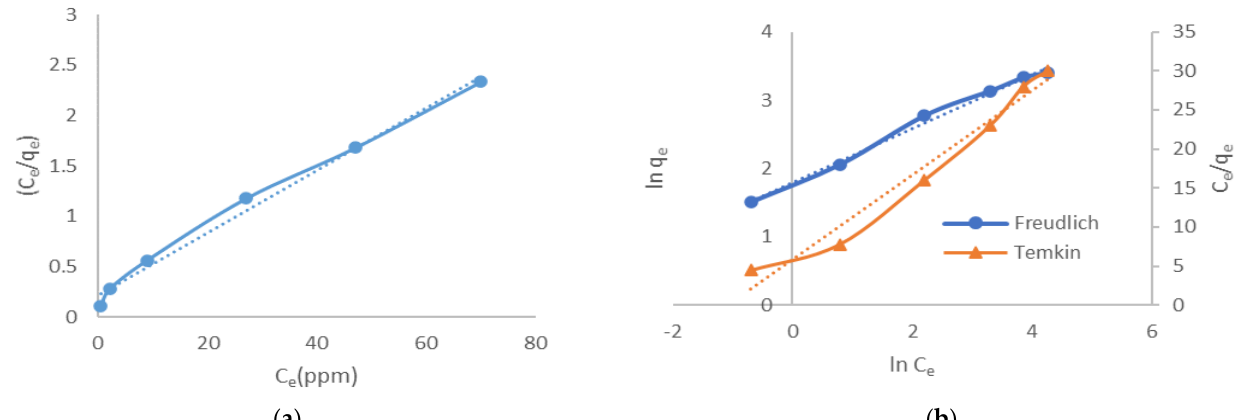
Figure 10. Isotherm plots for the adsorption of CV using LCF (C 0 = 25, 50, 75, and 100 ppm; m = 0.025 g; contact time = 5 min): ( a ) Langmuir and ( b ) Freundlich and Temkin isotherm models. Table 3. Model parameters for adsorption isotherm study of adsorption CV by LCF. Langmuir Freundlich